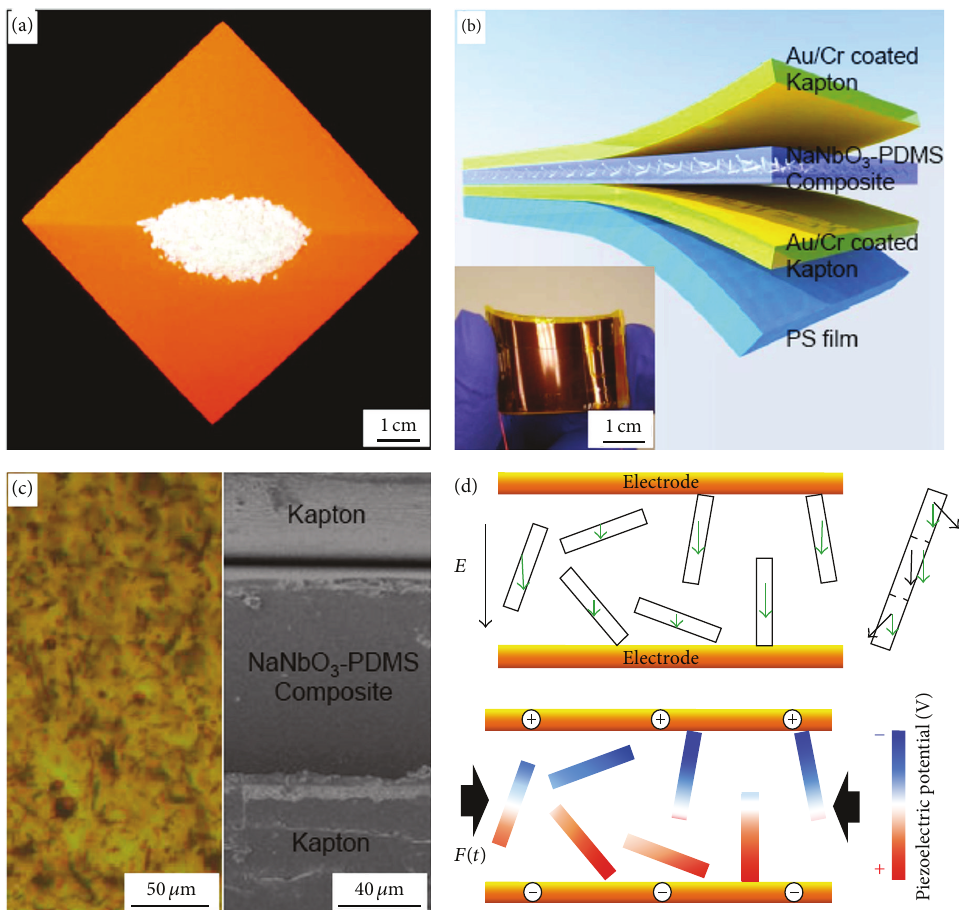
Figure 12: The structure and characterization of NaNbO 3 nanogenerators. (a) Photograph of NaNbO 3 nanowire powder. (b) Structural diagram of the NaNbO 3 nanogenerators. (c) AFM and SEM images. (d) The working mechanism of the NaNbO 3 nanogenerators. (Reproduced from [9] with the permission from American Chemical